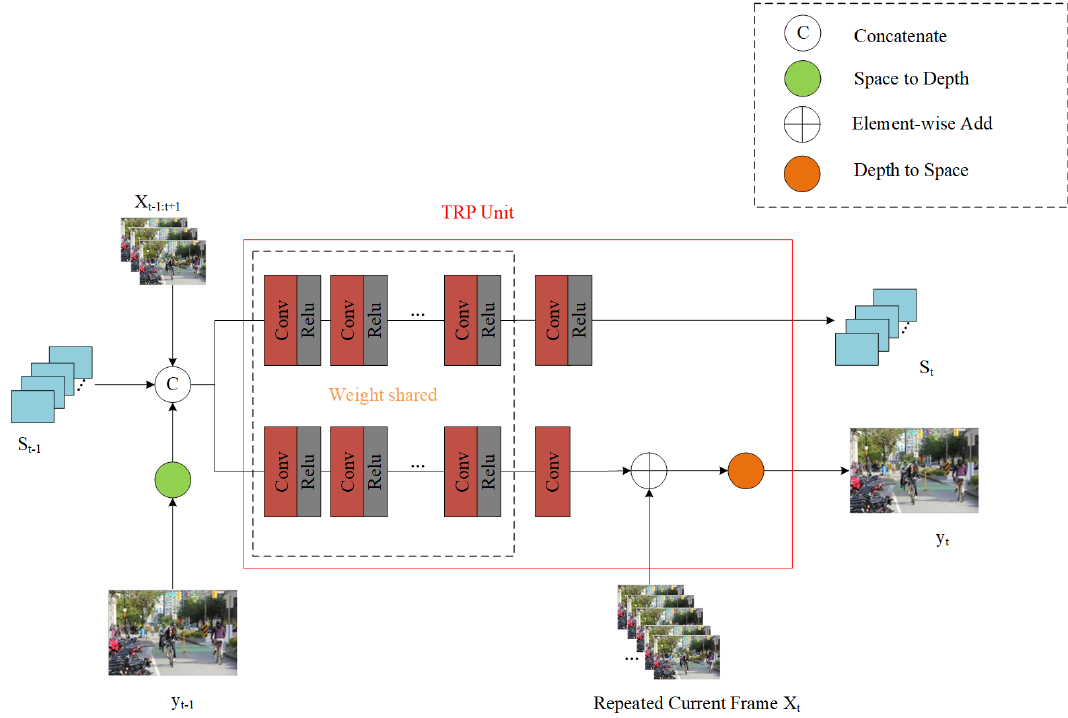
Figure 2. The architecture of the proposed TRP (Temporal-Recurrent Propagation)